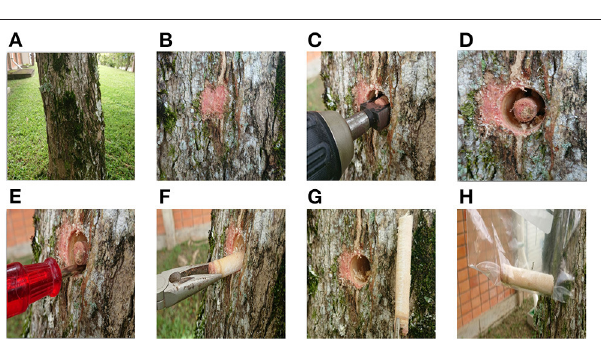
FIGURE 3 | (A–H) Extraction process of a sample of